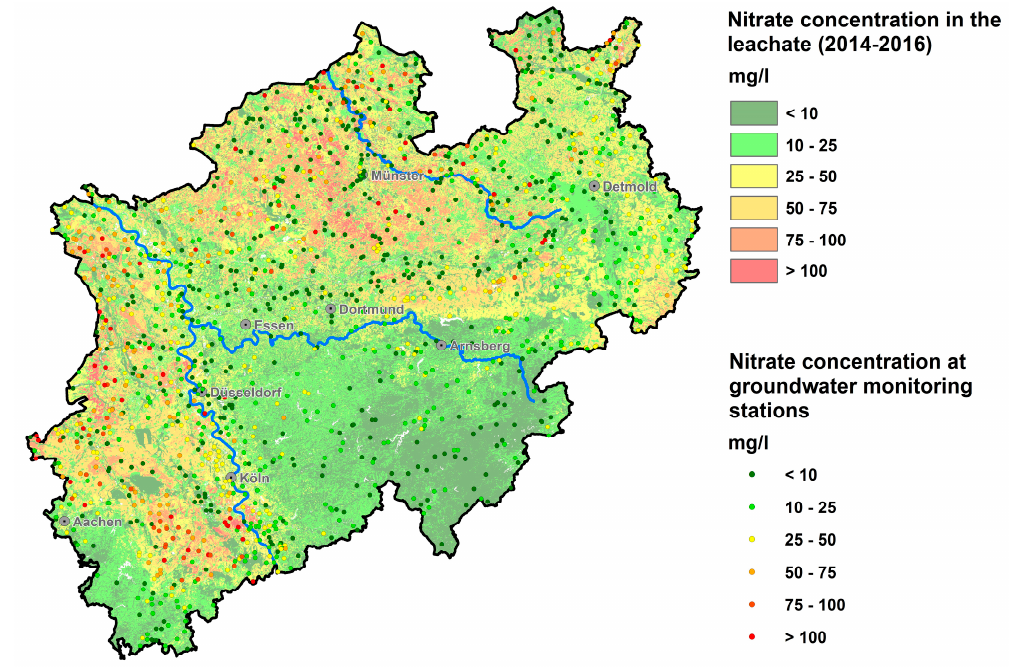
Figure 8. Plausibility check of the mean annual nitrate concentration in the leachate. The dots show observed values at groundwater monitoring sites—the underlying colored areas are the modelled nitrate concentrations in the leachate per grid.